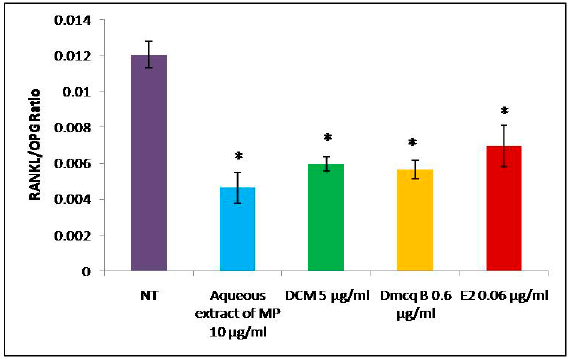
Figure 10. Effects of M. pumilum var. alata crude aqueous extract, DCM fraction, Dmcq B and E2 (positive control) on RANKL/OPG ratio. All M. pumilum var. alata treatments showed significantly lower RANKL protein expression followed by an increment of OPG protein expression, hence the RANKL/OPG ratio was decreased for all the treatments, resembling the effects of E2 treatment. The data are presented as means of percentage of treatment ± SEM; n = 6. * Significantly different ( p < 0.05) compared to NT group. NT non-treated group MP M. pumilum var. alata crude aqueous extract